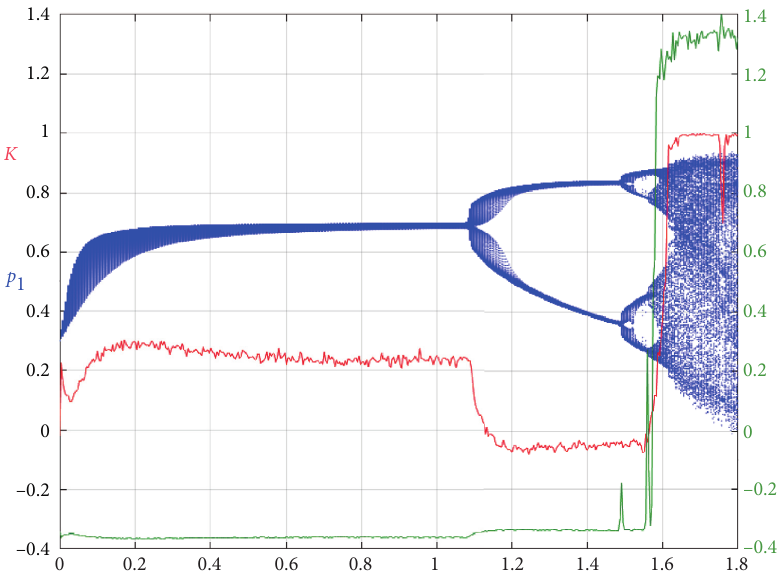
Figure 4: Firm 1’s price diagrams of bifurcation ( p correlation coefficient ( K , red) in system (14) with varying a ∈ ( 0 , 1 . 8 )